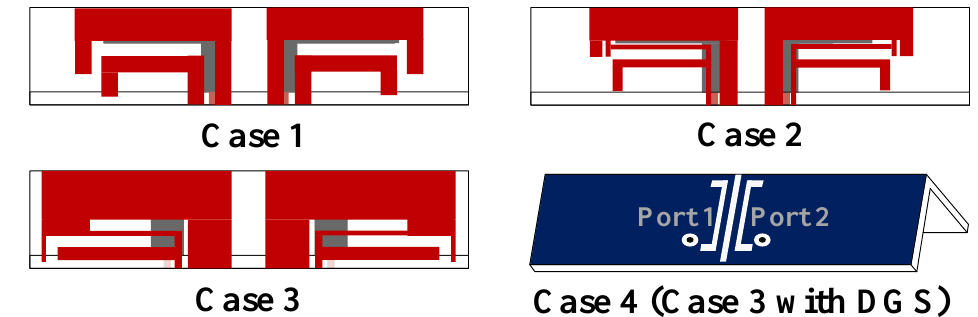
Figure 2. Design evolution of the proposed antenna pair.